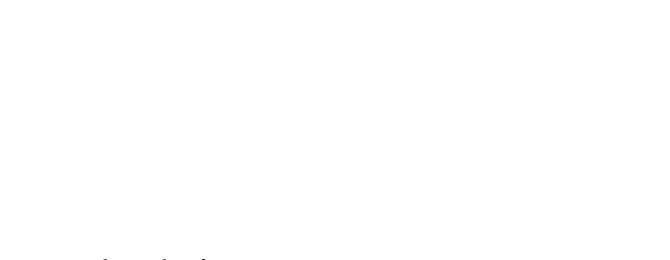
Table 9. Effect of N and A on the average Nusselt number for Case